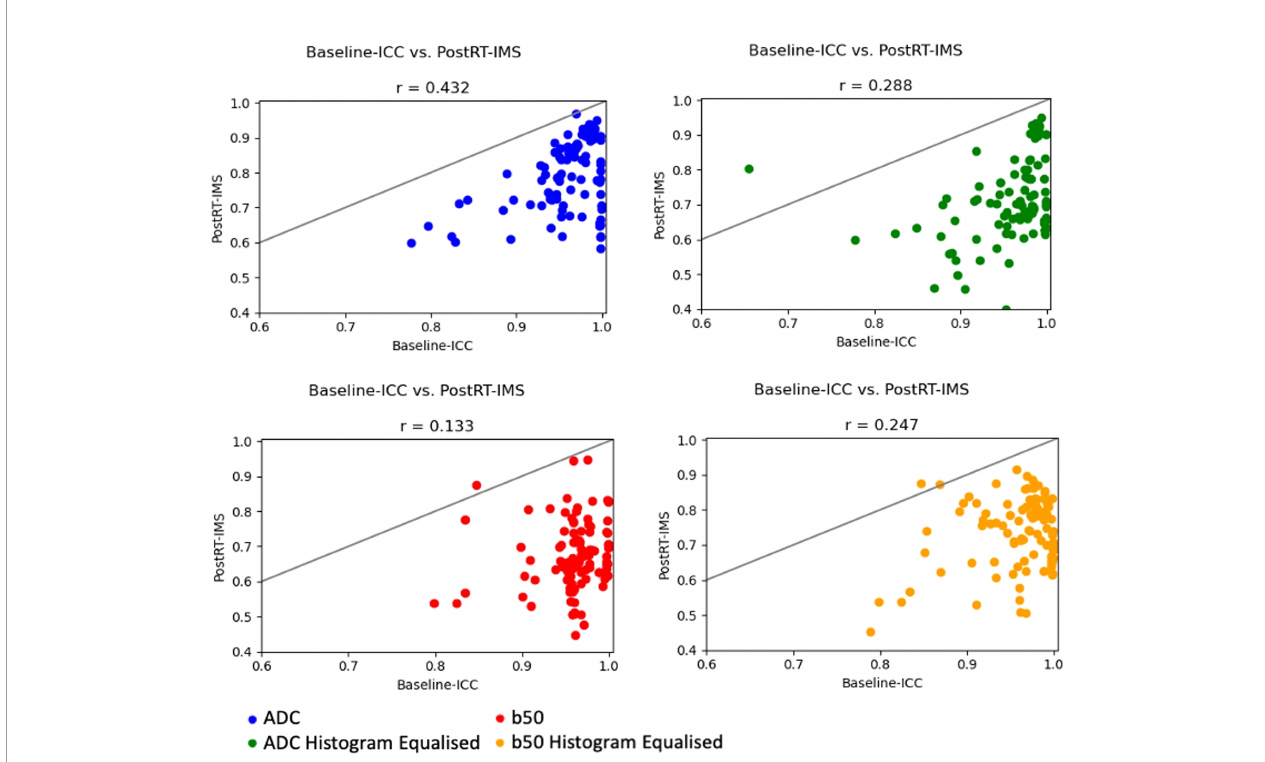
FIGURE 2 | ICC – IMS correlation plots. Correlation plots showing the baseline ICC vs. the post-RT-IMS for all radiomic features for each image type. A solid line of equality is shown in each. The Pearson correlation coef fi cient ( r ) is shown as a